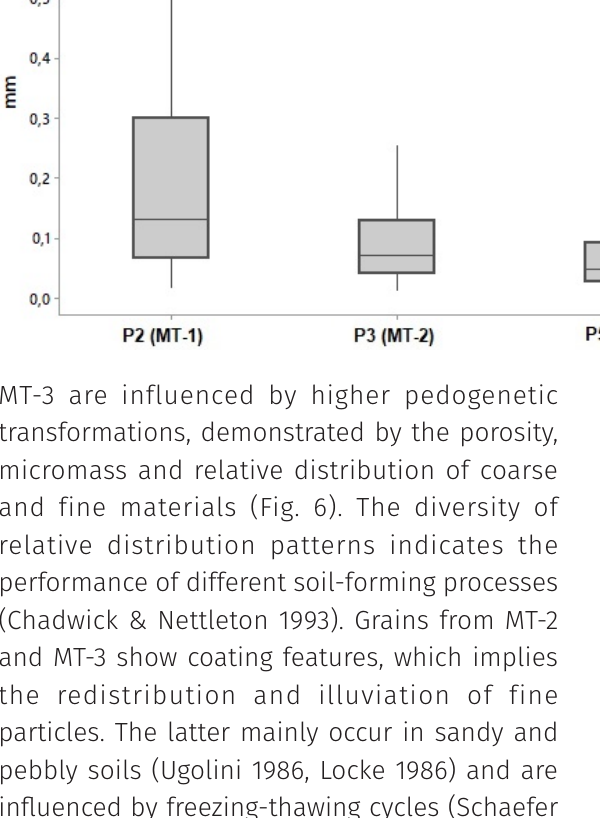
Figure 8. Boxplot of Cox roundness indices of the grains from distinct kinds of soils. MT: marine